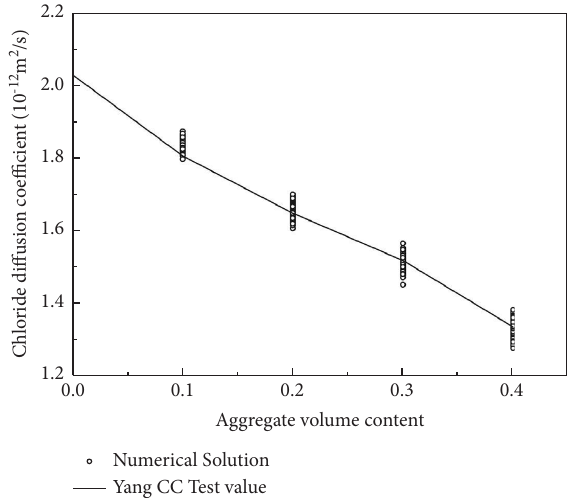
Figure 3: Numerical solution versus Yang test